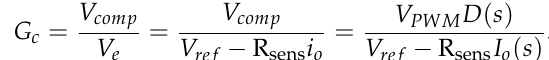
Figure 7. Closed system block configuration of DCM converter.